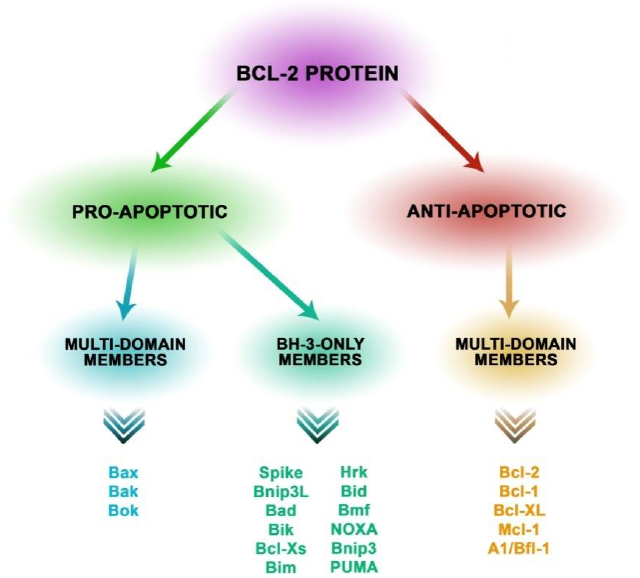
Figure 1. Classification of proteins from the Bcl-2 family into three subfamilies determined by the presence of the Bcl-2 domain. The family of proapoptotic Bax proteins structurally contains the BF1-3 domain and trans membrane domain (TM). This genus of subfamily forms channels in the mitochondrial membrane. The representatives are Bax, Bak, and Bok. Proapoptotic proteins also include the subfamily with the BH-3-only domain such as Bad, Bim, Bik, Bmf, Bid, Bnip3L, Bnip3, Hrk, Noxa, Puma, and Spike. The essential function of these proteins is to induce apoptosis as a response to cellular stress. The subfamily of apoptotic proteins that structurally contain BH 1-4 and TM has the function of maintaining the integrity of the mitochondrial membrane. This subfamily includes the following proteins: Bcl-2, Mcl-1, Bcl-XL, Bcl-w, Bcl-1, and A1